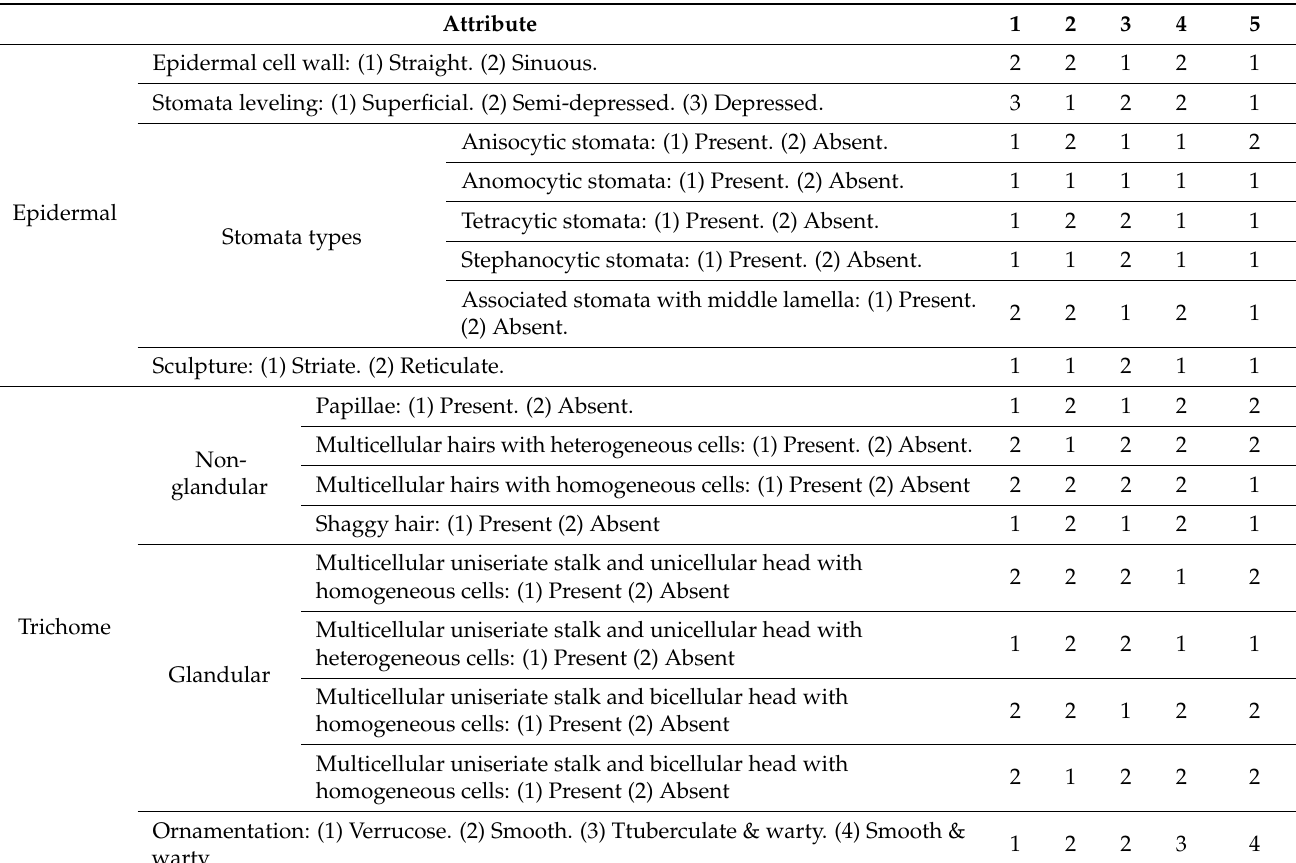
Table 2. Micro-morphological characters of epidermis and trichome in the studied taxa. Attribute 1 2 3 4 5